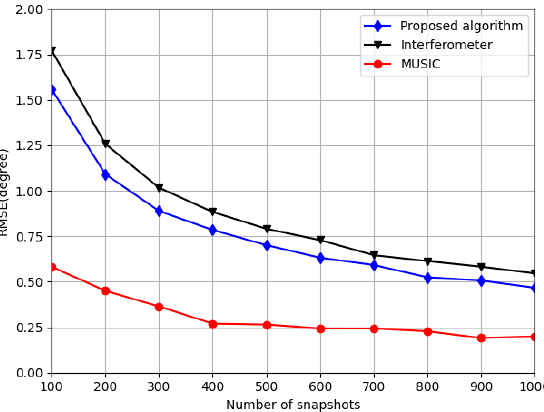
Figure 6. Relationship between estimation error and the number of snapshots.